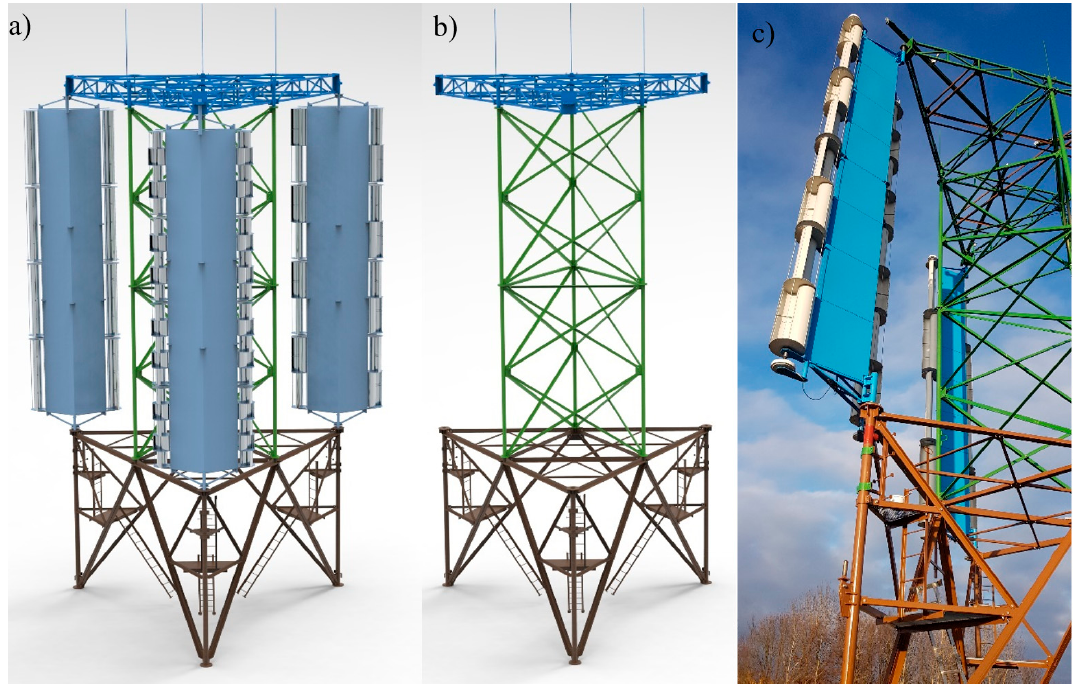
Figure 2. ( a ) wind turbine; ( b ) wind turbine tower; ( c ) wind turbine side view.